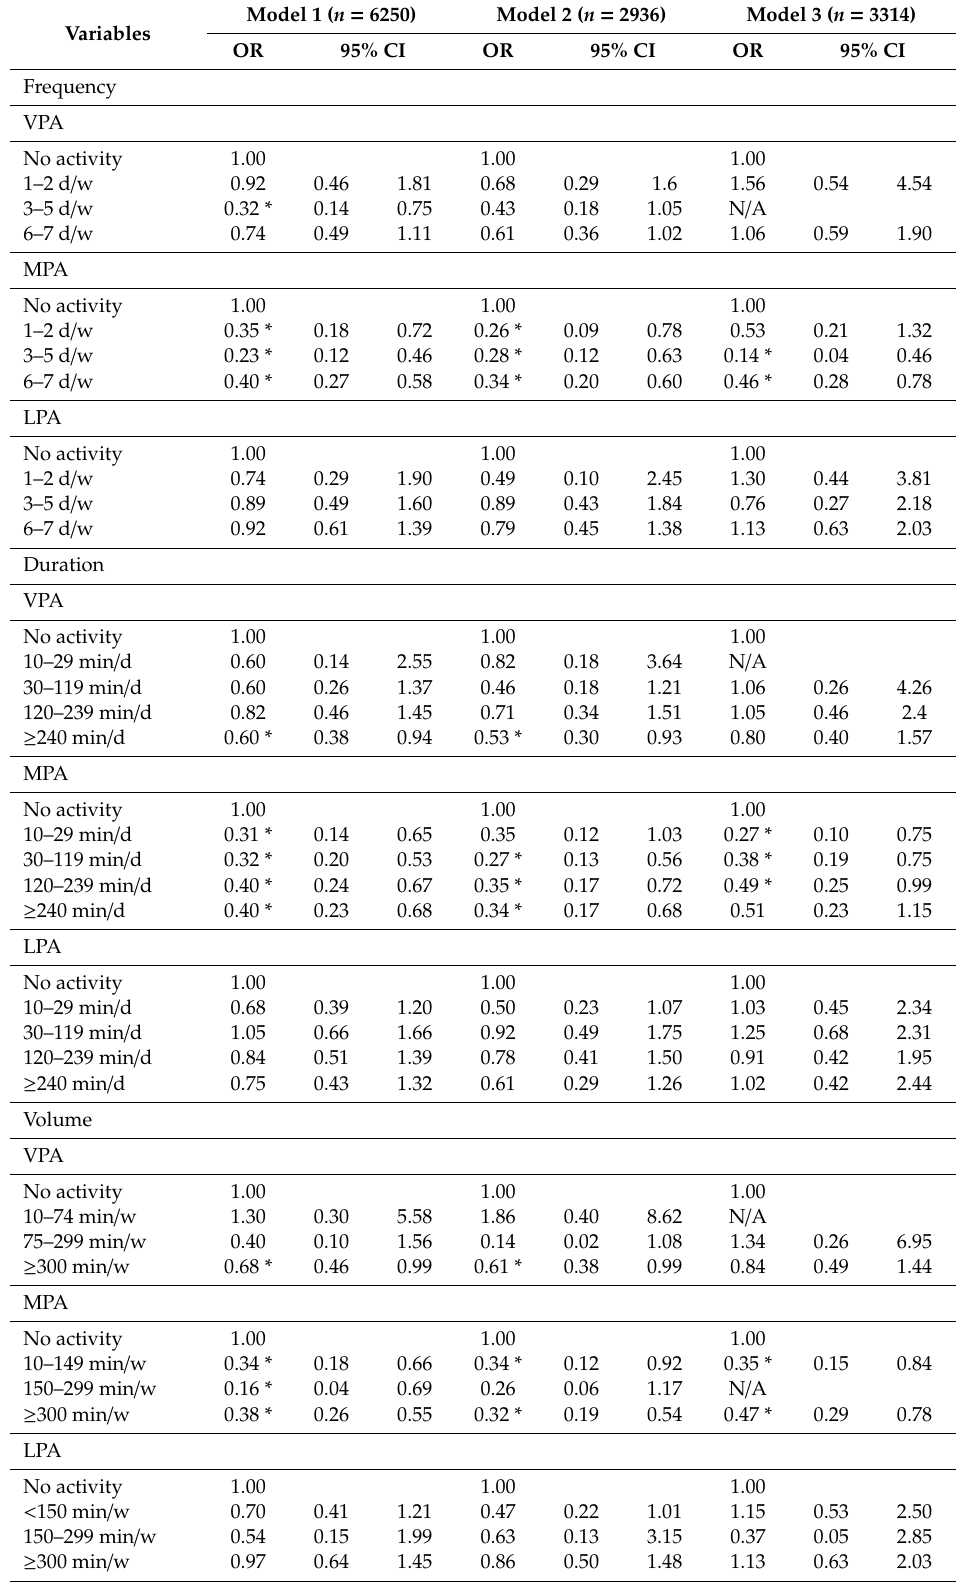
Table 2. Associations between PA and the risk of